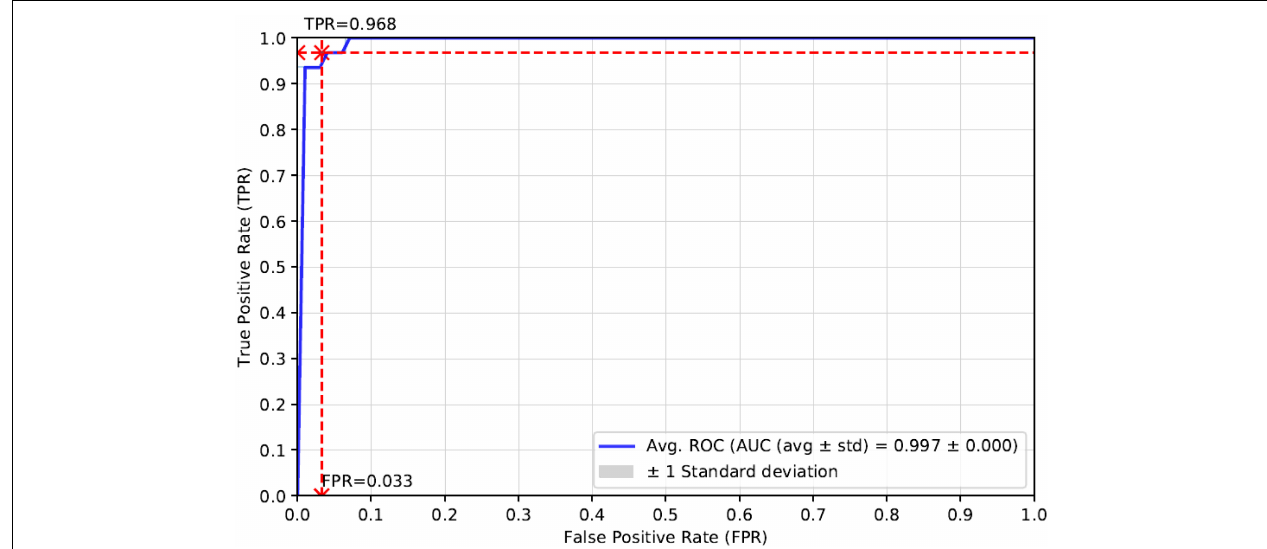
FIGURE 4 | ROC curves for independent test validation of our proposed